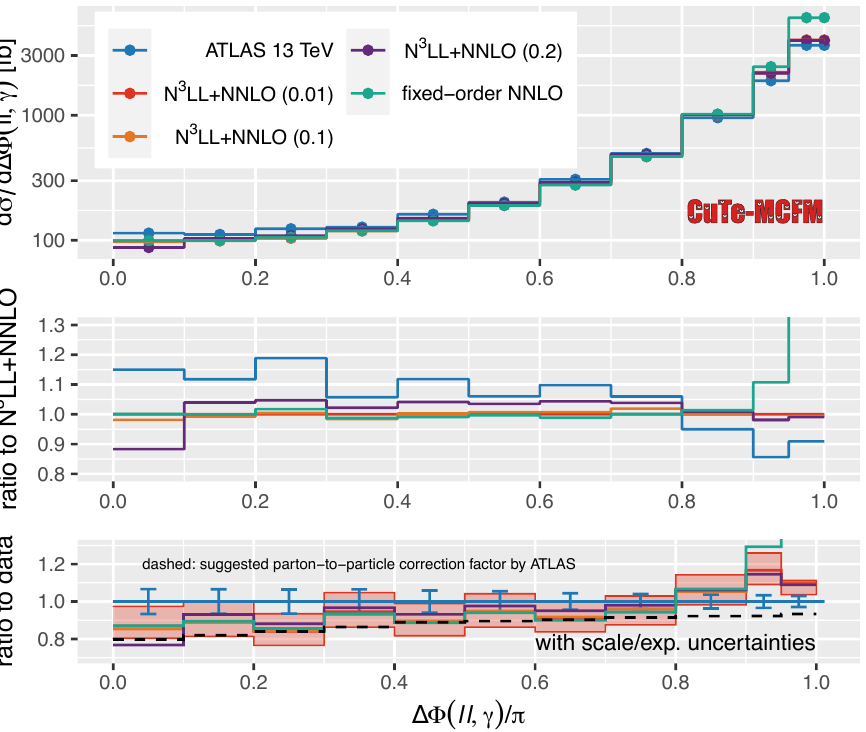
Figure 24. Comparison of N 3 LL+NNLO predictions with ATLAS measurement of ∆ φ ( ll, γ ) at 13 TeV . Note that this plot includes the last two bins individually that are only shown combined for the NNLO fixed-order comparison in ref. [133]. The labels 0 . 01 , 0 . 1 and 0 . 2 in the plots refer to the value of x max